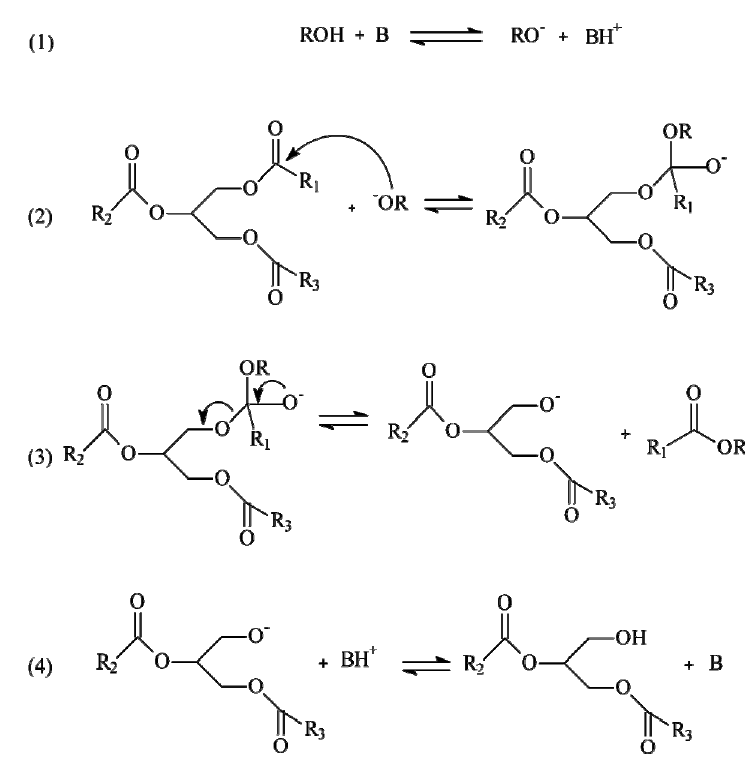
Figure 1. Mechanism of basic transesterification